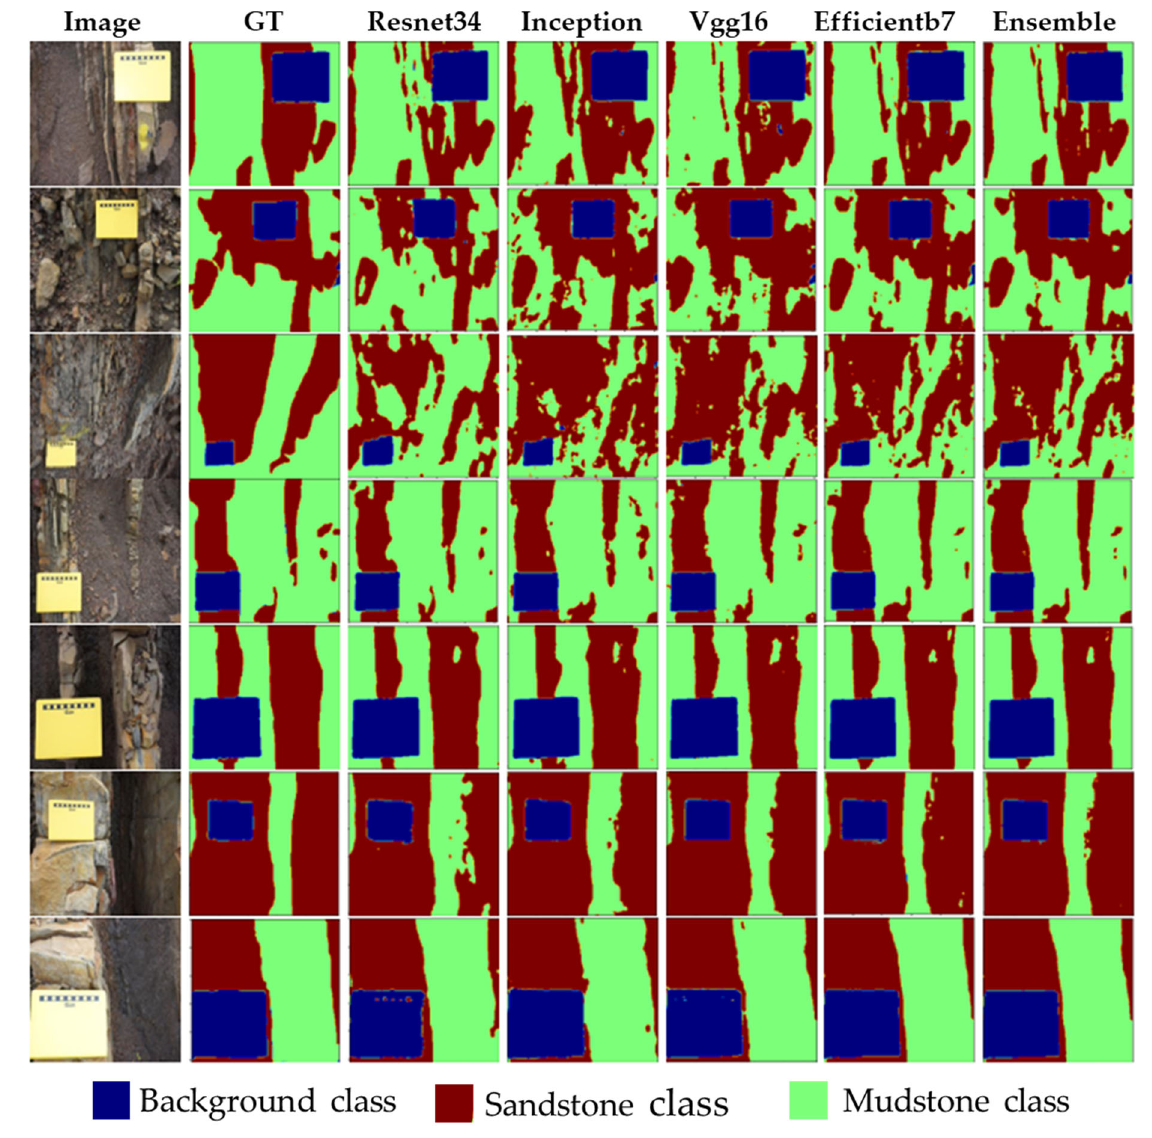
Figure 9. Prediction results for LinkNet model with different backbones.